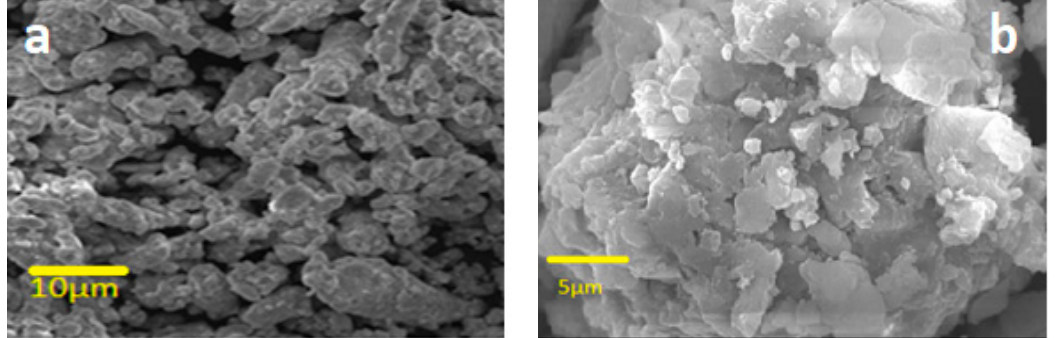
Figure A3. SEM image of ( a ) Al 2 O 3 NPs and ( b ) SiO 2 NPs.